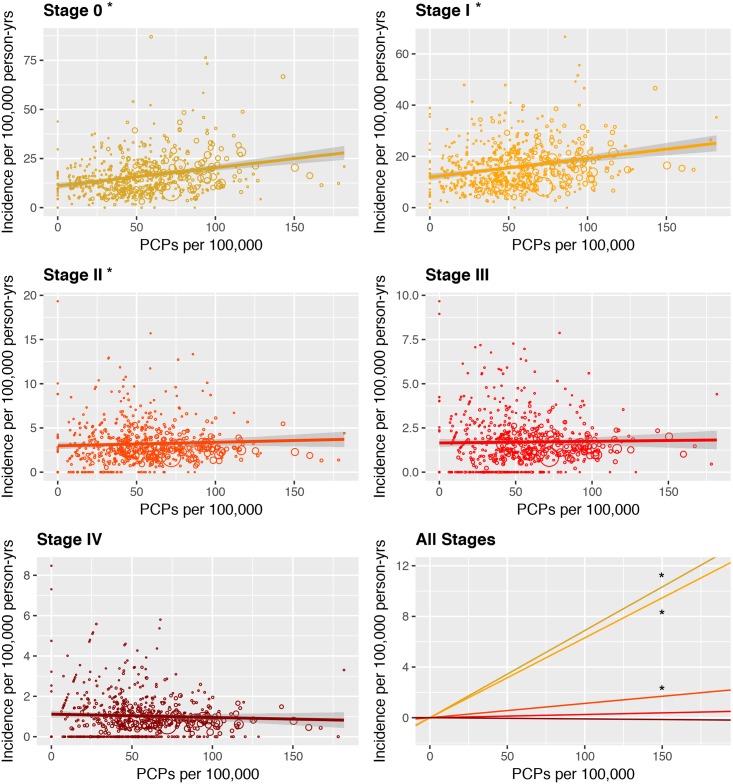
Incidence as a function of PCP density, stratified by stage at diagnosis.Melanoma incidence per 100,000 person-years shown as a function of PCPs per 100,000 people across all US counties in SEER from 2008–2012, split by AJCC stage at diagnosis. Points are scaled in size by total county population, and the 95% CI for each line of fit is shown in gray. Stages 0, I, and II were statistically significant (*), and the last panel compares coefficients for all stages.